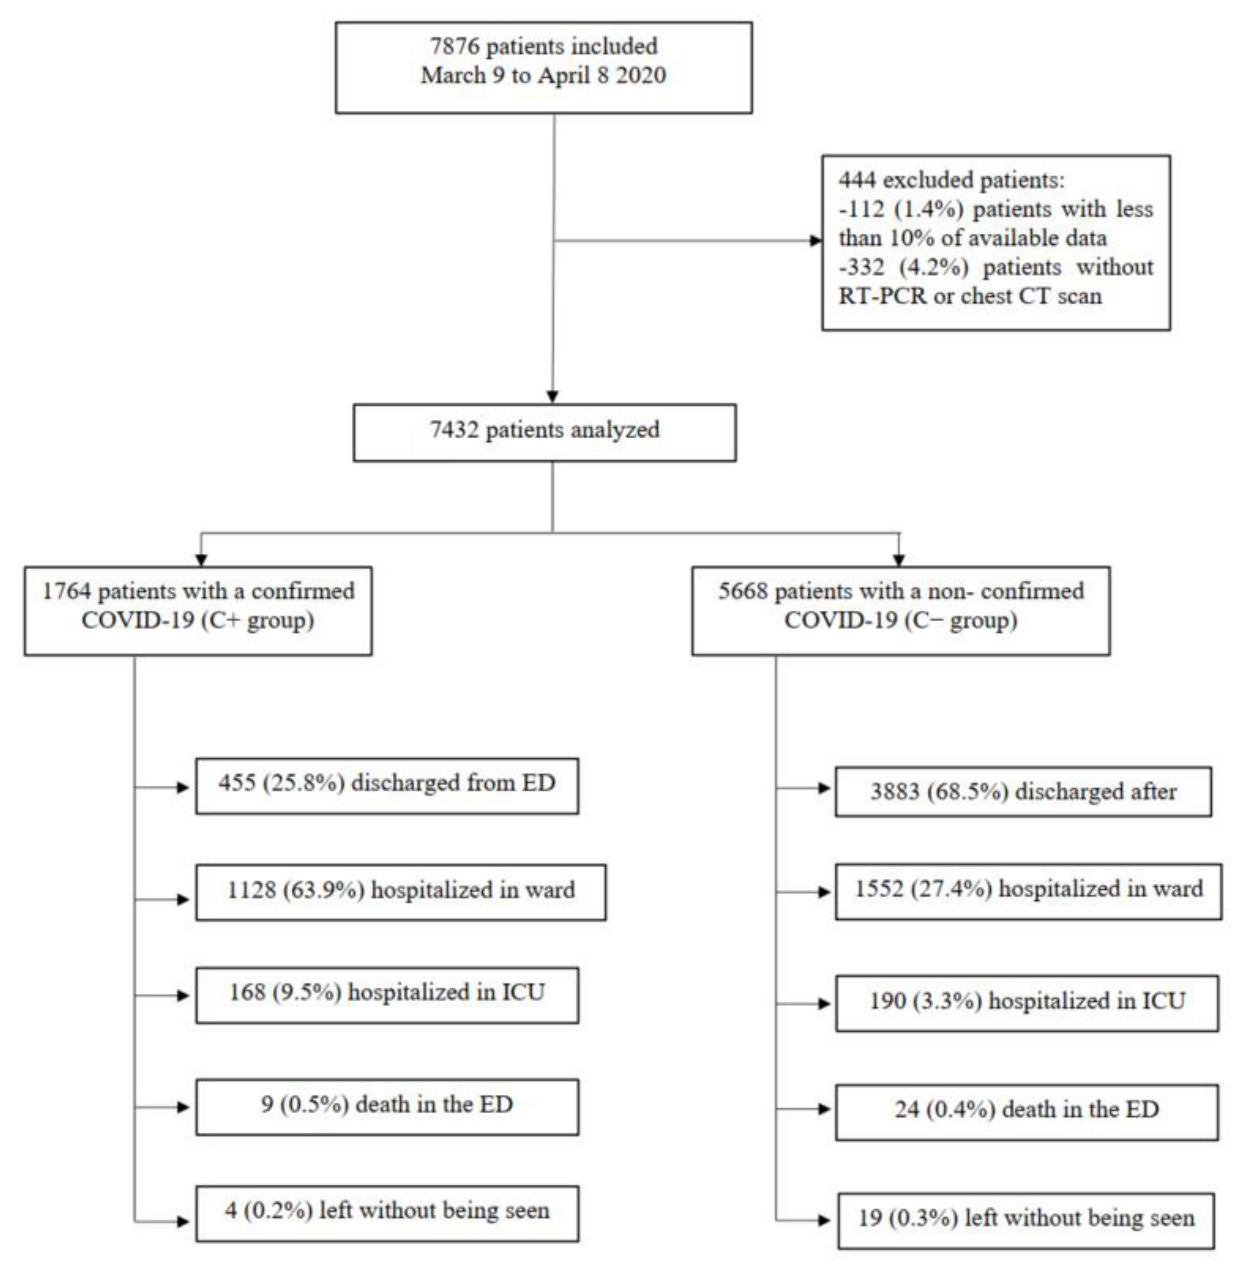
Figure 1. Flow chart of patients included in the study. Table 1. Details of patients